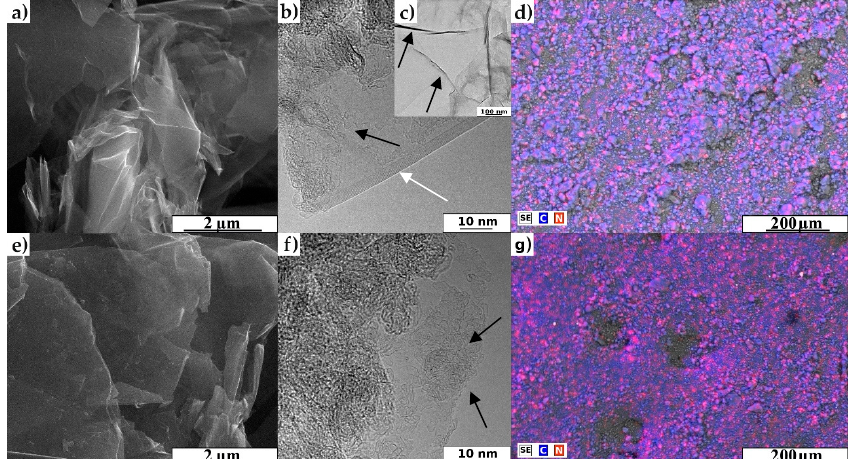
Figure 1. Representative images of obtained samples: ( a ) SEM image of GF_750_D_1D sample, ( b ) HRTEM image of GF_750_D_1D sample, ( c ) HRTEM image of pristine GF_750_raw sample, ( d ) SEM / EDX mapping of GF_750_D_1D sample, ( e ) SEM image of GF_750_W_3D, ( f ) HRTEM image